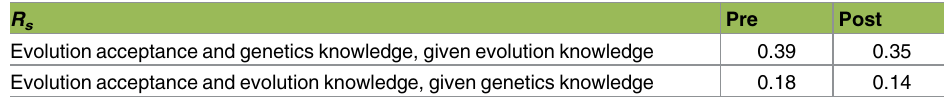
Table 2. Partial Spearman correlations between evolution acceptance and genetics knowledge, con- trolling for evolution knowledge and evolution acceptance and evolution knowledge, controlling for genetics knowledge. All correlationsare highlysignificant( p < .001). Raw data can be found in S1 and S2 Data. R s Pre Post Evolution acceptance and genetics knowledge, given evolution knowledge 0.39